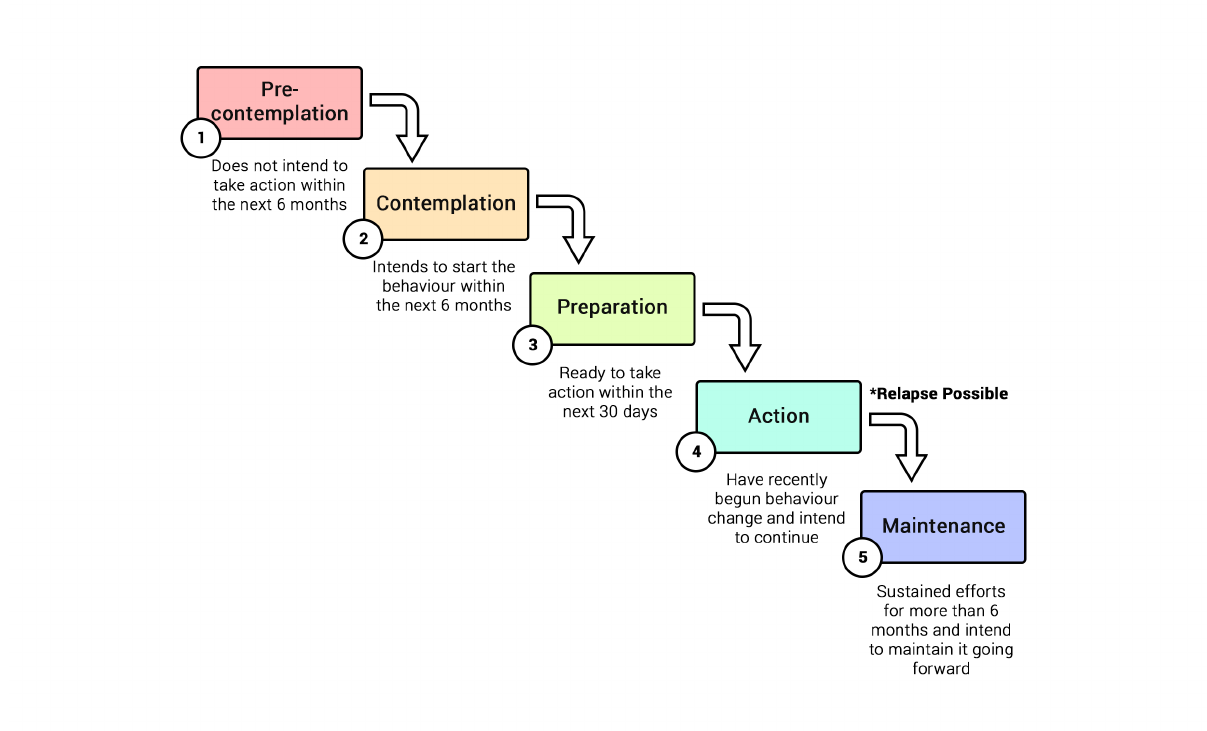
Figure 1. Stages of behavior change within the Transtheoretical